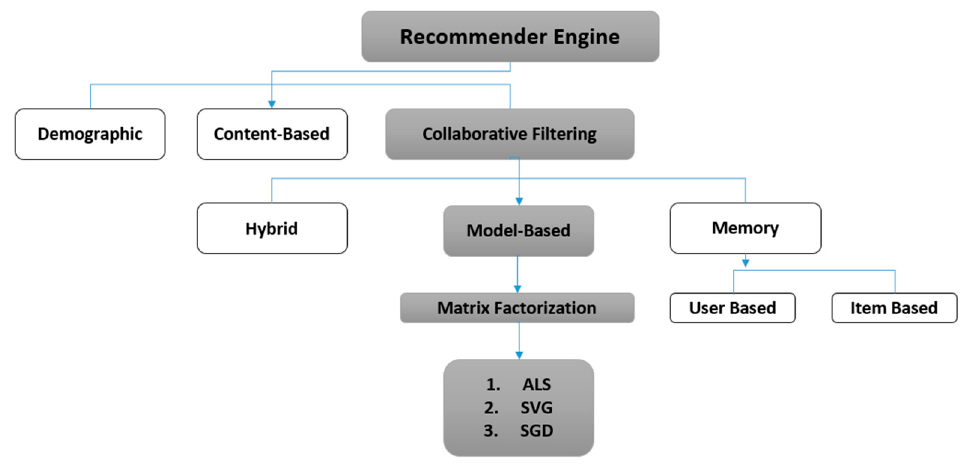
Figure 1. Basic structure of the recommendation engine.